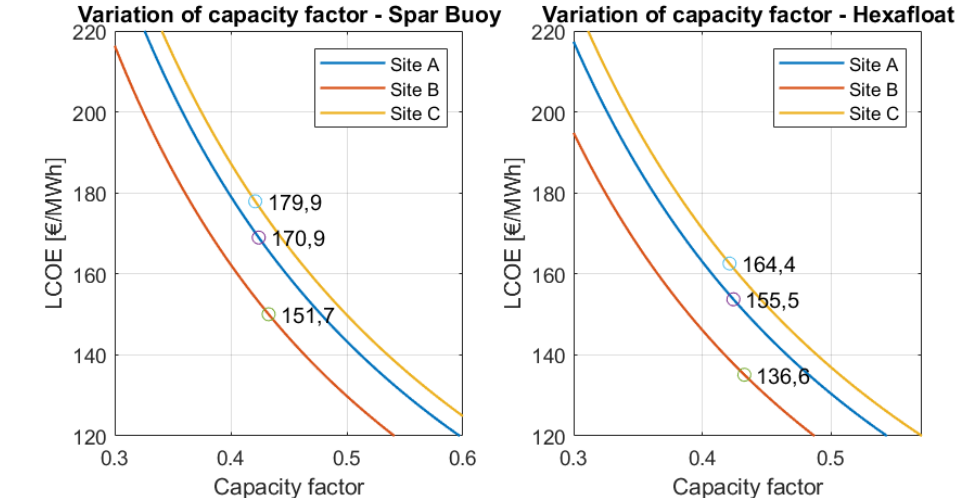
Figure 18. Influence of Capacity Factor for sites A, B, and C for both